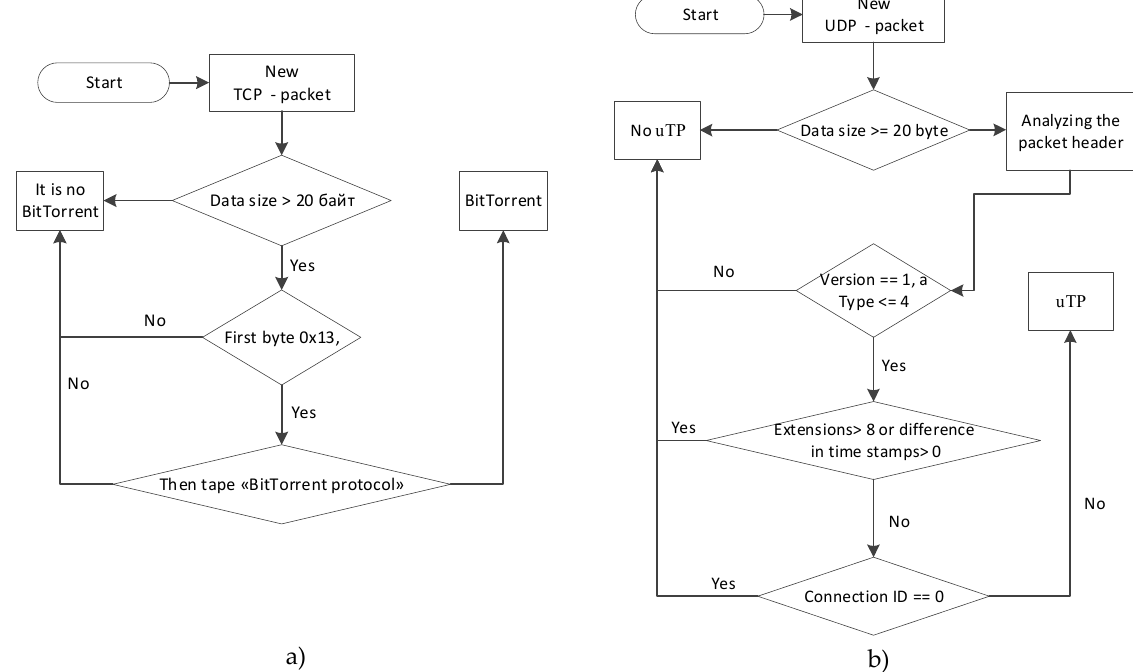
Figure 16. Algorithms for BitTorrent (a) and uTorrent Transport Protocol (uTP) (b) detection.